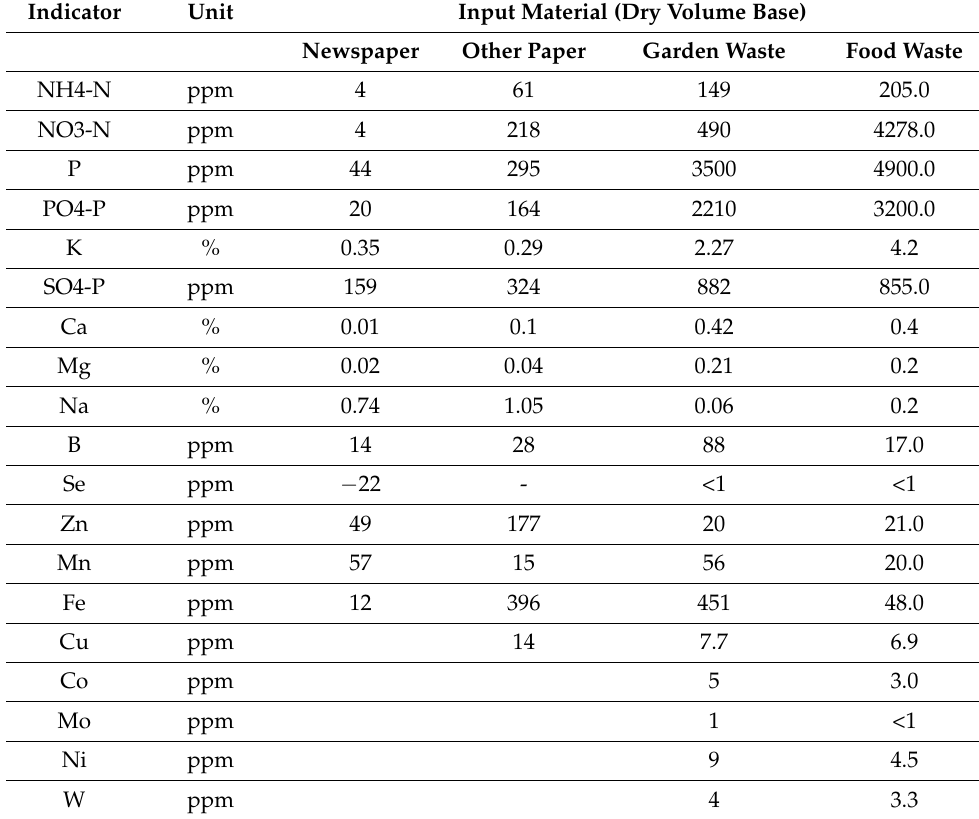
Table 6. Element of organic waste in MSW for bio transformation in Vietnam (Source: Dieu T.M. Tran, [25]. Indicator Unit Input Material (Dry Volume Base) Newspaper Other